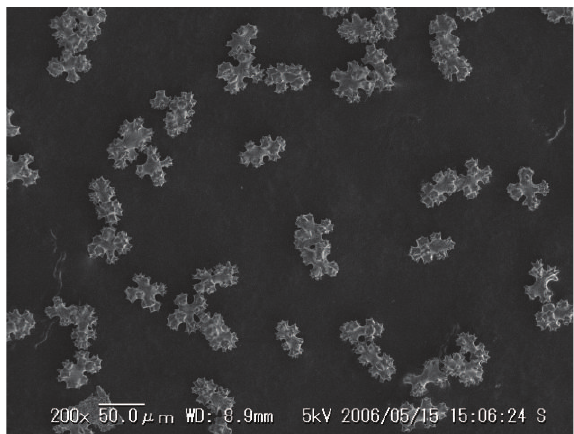
Figure 6: SEM image of sclerites of Paracorallium japonicum ; OCA- Cn20060211-031.